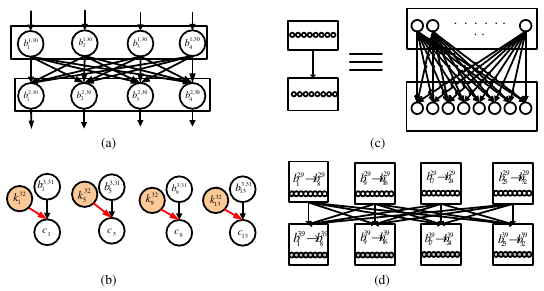
Figure 3: Example: Subgraphs corresponding to different sub-operations of a cipher